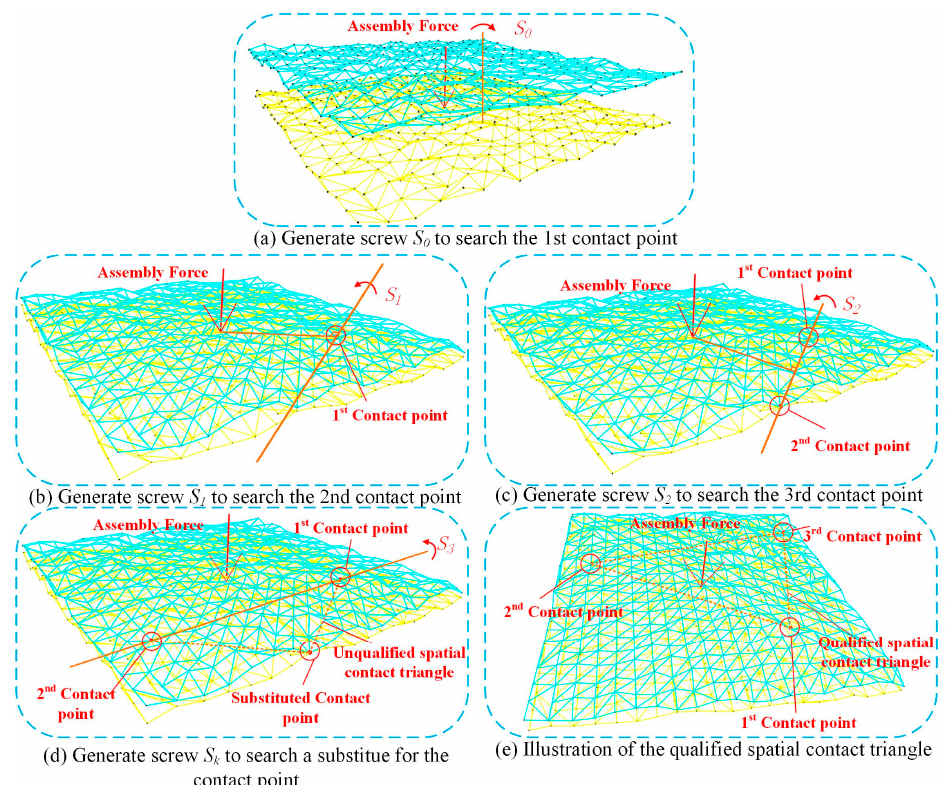
Figure 3. Main steps in the computation of assembling condition when considering assembly force constraints.